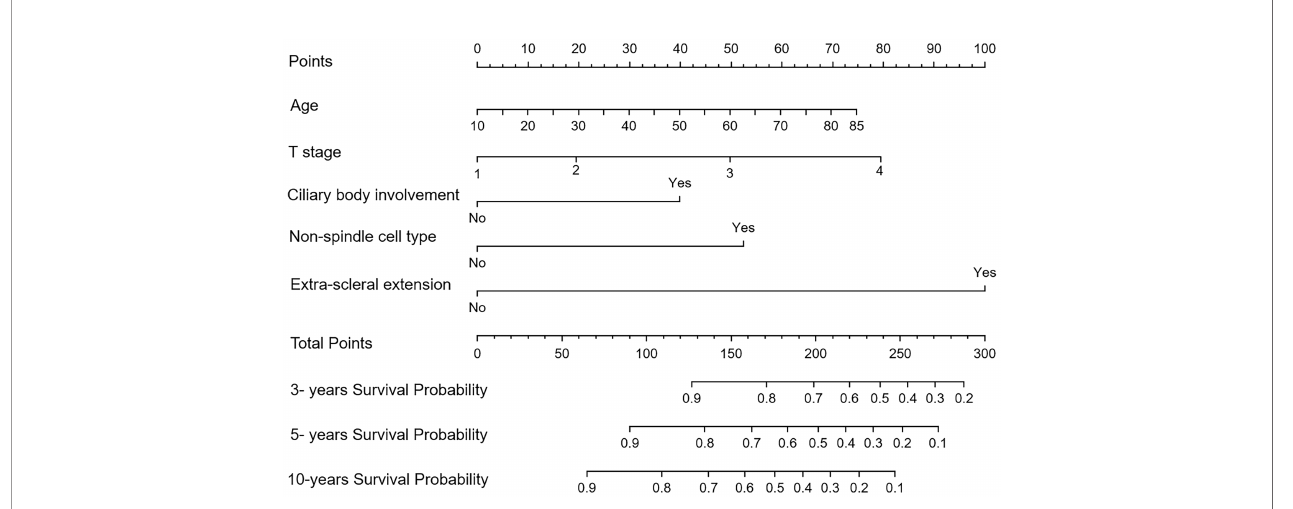
FIGURE 3 | The nomogram for the overall survival of patients in the training cohort (Model II).